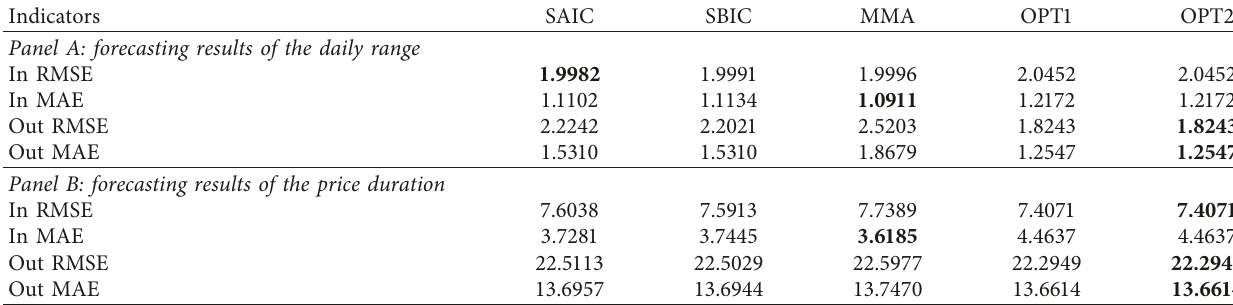
Table 4: Forecasting results by model averaging estimator.